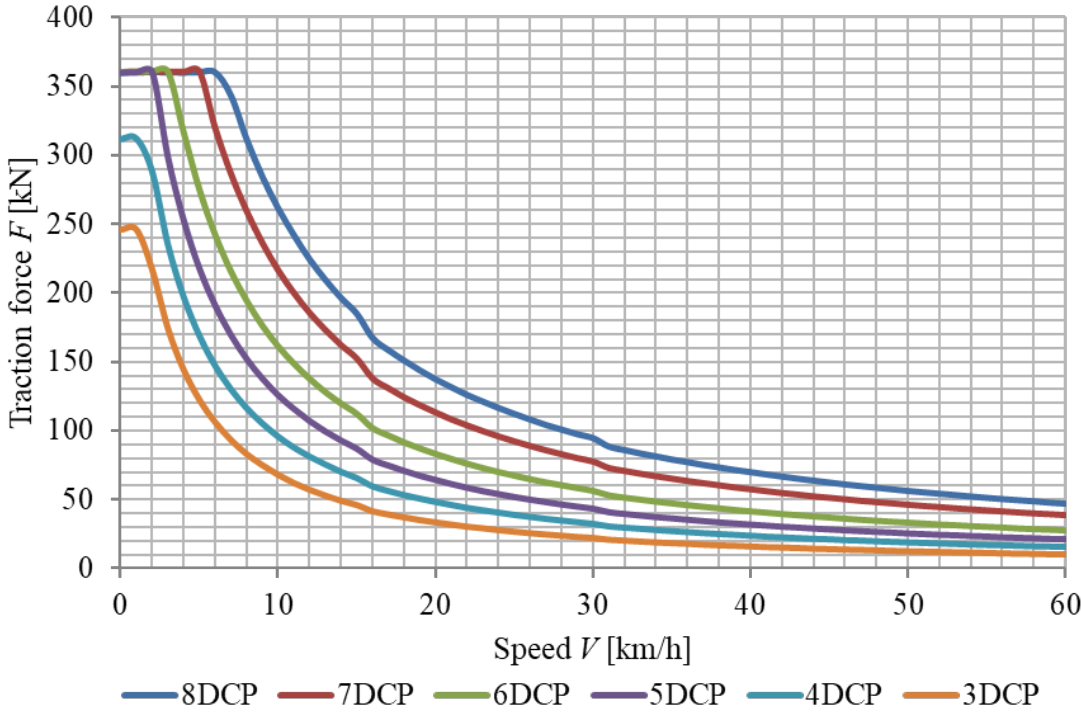
Figure 6. Estimated traction characteristics of the ChME3 locomotive (3DCP-8DCP—position number of the driver’s controller from 1 to 8 respectively). Source: own work.